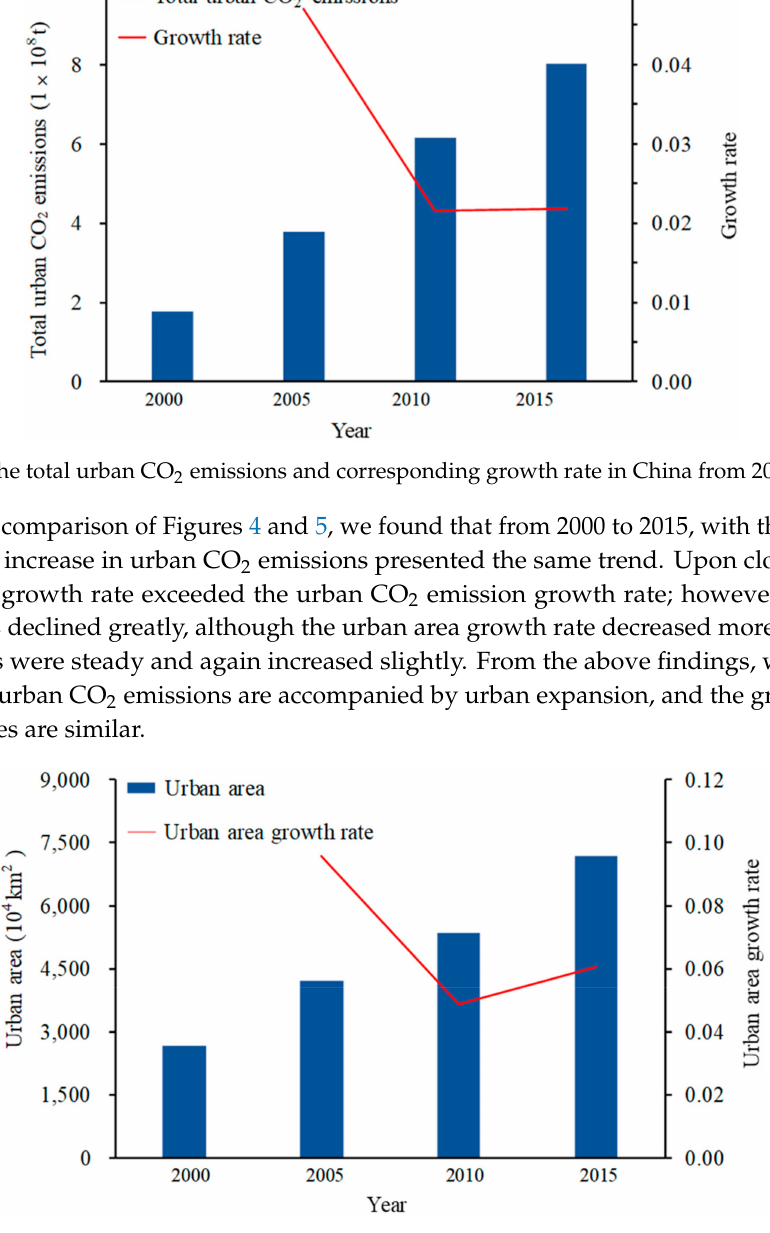
Figure 5. Urban area and corresponding growth rate in China from 2000 to